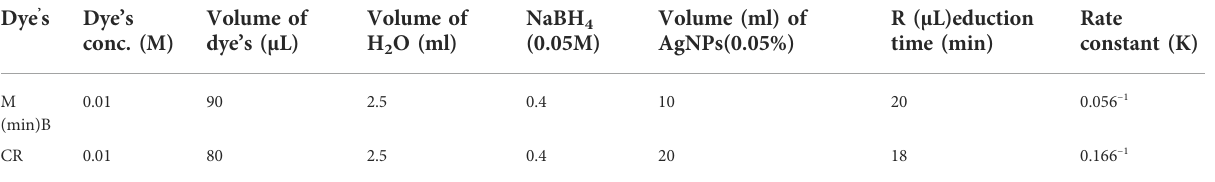
TABLE 1 Detail of experiment for catalytic degradation of